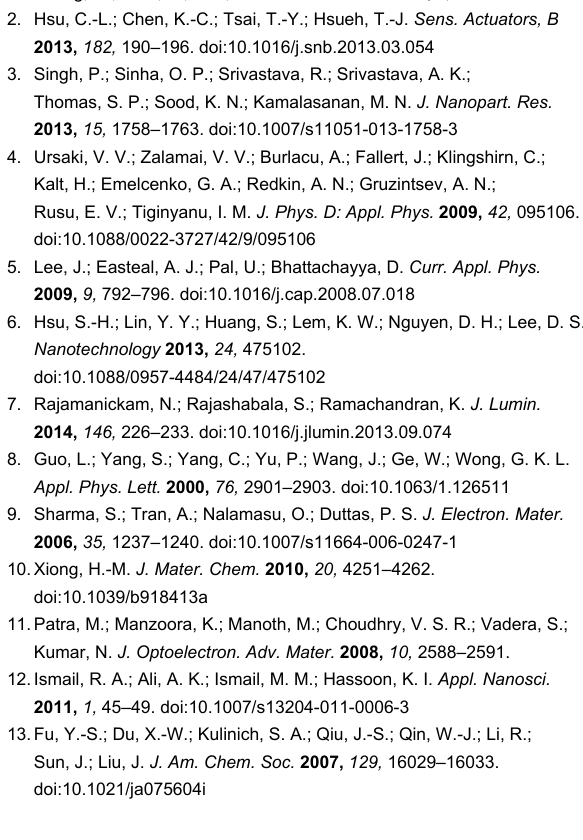
Figure 5: FTIR spectra of pure ZnO nanoparticles (1), ZnO/PVP composite (2), and pure PVP (3).